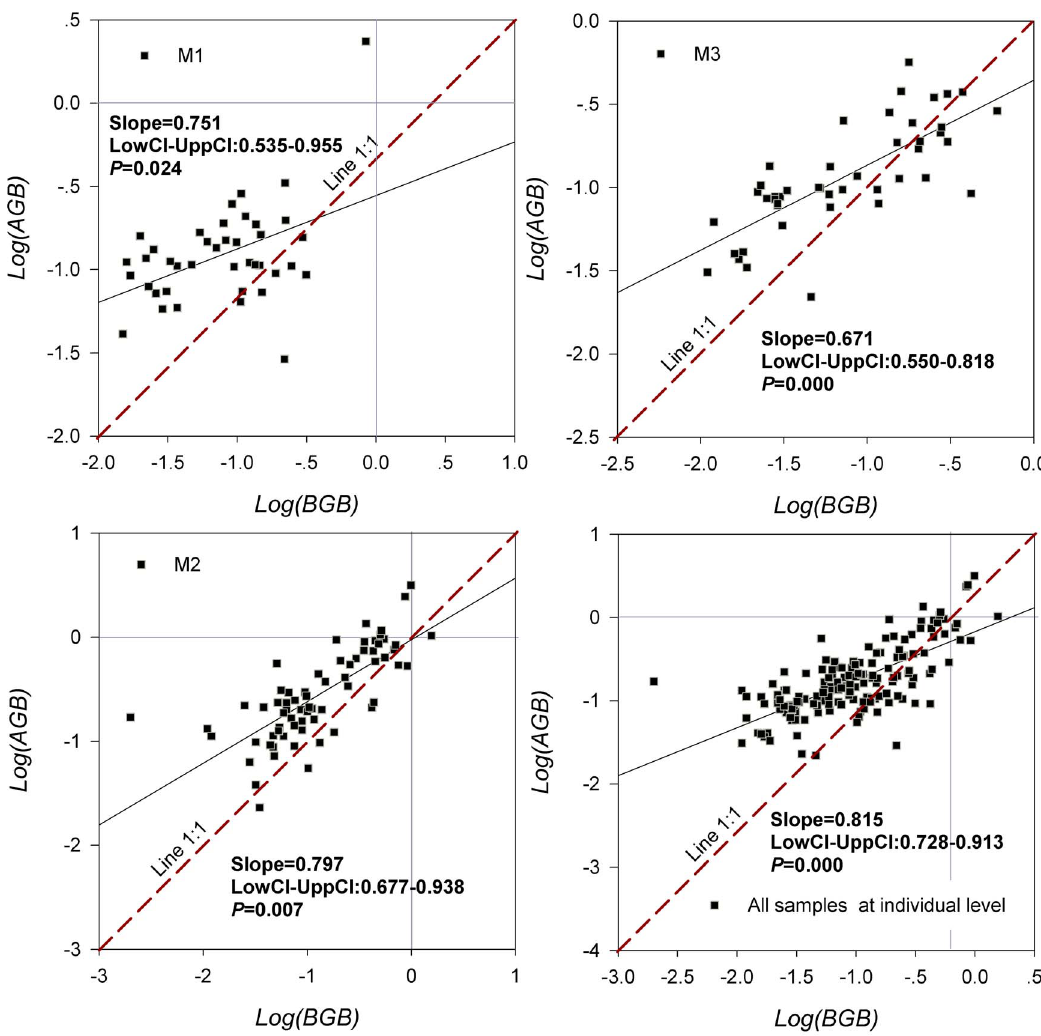
Figure 3. Relationships between AGB and BGB under grazing (M1), seasonal grazing (M2), and grazing exclusion (M3) regimes.